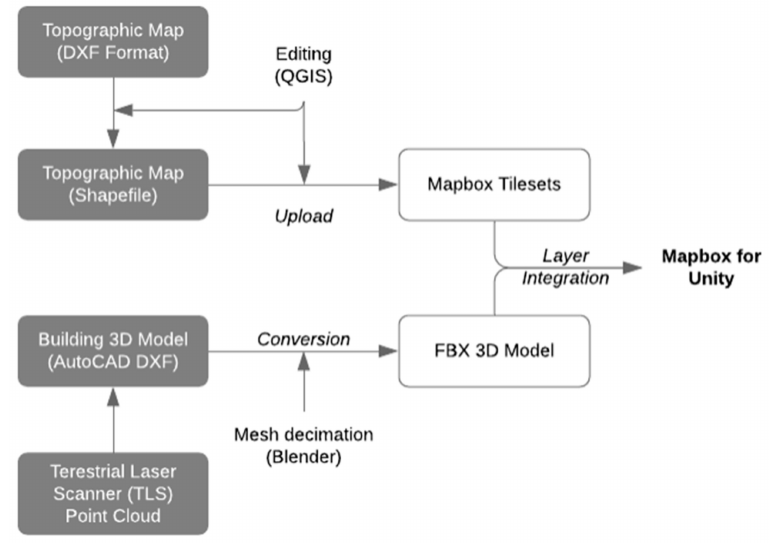
Figure 1. Data preparation workflow for Mapbox with Unity.